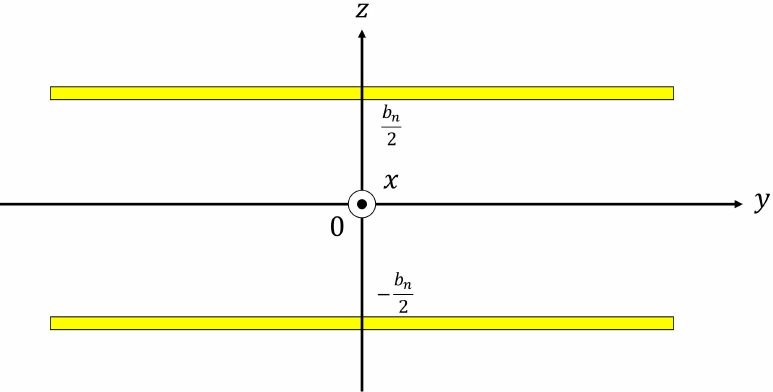
Figure 9. Cartesian coordinate system for the parallel clearance between the two planes.